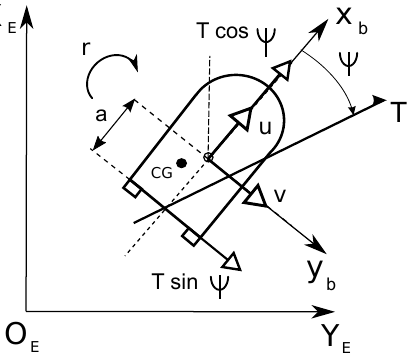
Figure 1. Underactuated hovercraft model